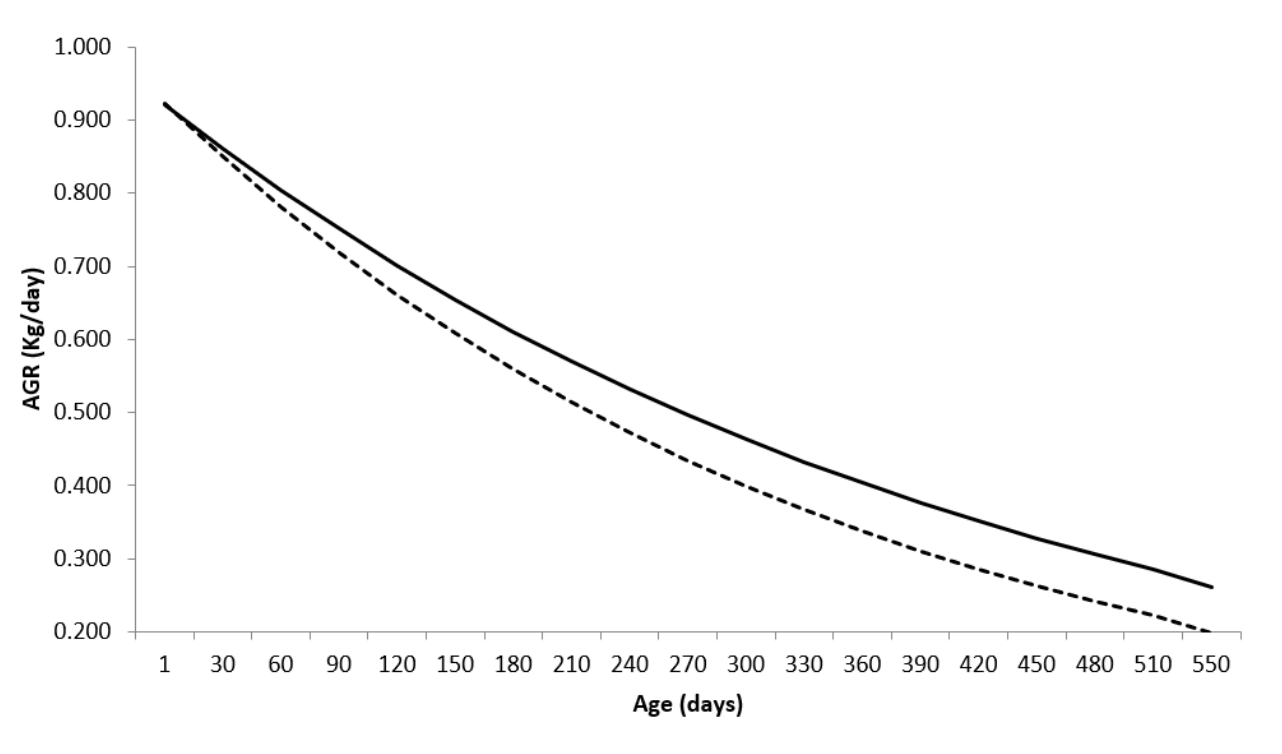
Figure 2. Absolute growth rate (AGR) for Nelore breed males ( — ) and females ( ‑‑‑ ), using the Brody function in a mixed nonlinear model.